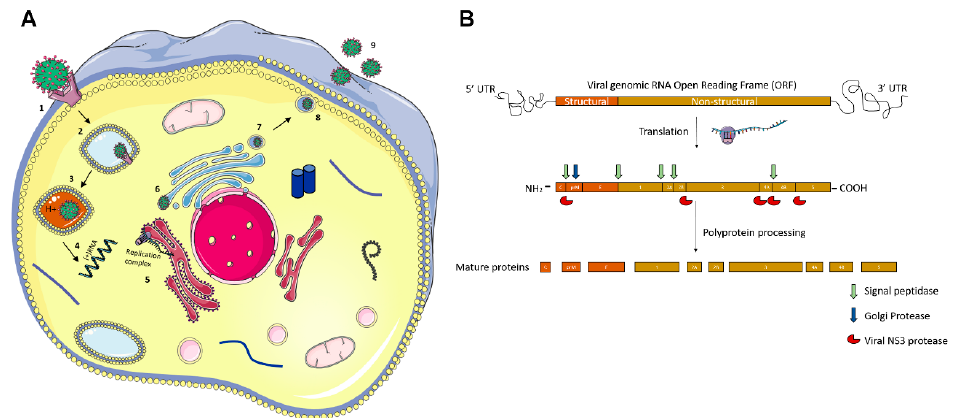
Figure 2. Flavivirus replication cycle and genome structure. ( A ) The flavivirus enters the host cell by attaching to specific receptors (1) which then leads to its endocytosis (2) followed by fusion to a lysosome into an acidic environment (3). The genome is released from the endolysosome (4) which is then translated on the Endoplasmic reticulum membrane (5) and post translational processing is done in the Golgi apparatus (6). The mature virus then buds off from the Golgi network (7) to the extracellular space via exocytosis (8, 9). ( B ) The genome consists of three structural proteins (Envelope (E), Capsid (C) and pre-membrane (prM)) and seven non-structural proteins (NS1, NS2A, NS2B, NS3, NS4A, NSB, and